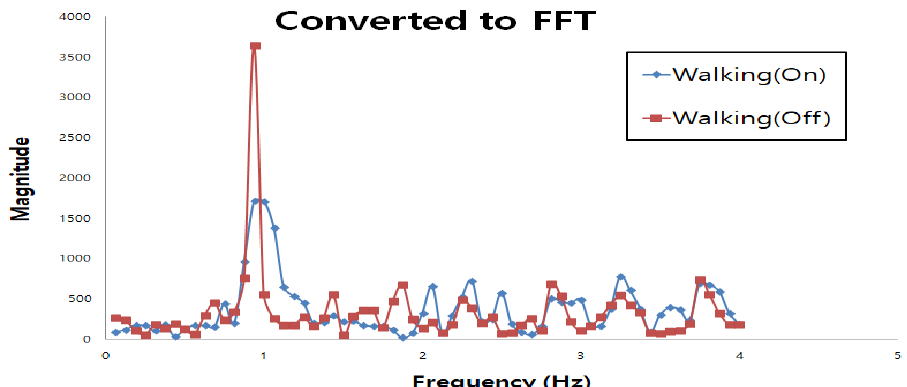
Figure 10. Results of Fast Fourier Transformation (FFT) conversion of walking activity according to whether or not the safety helmet was worn properly.